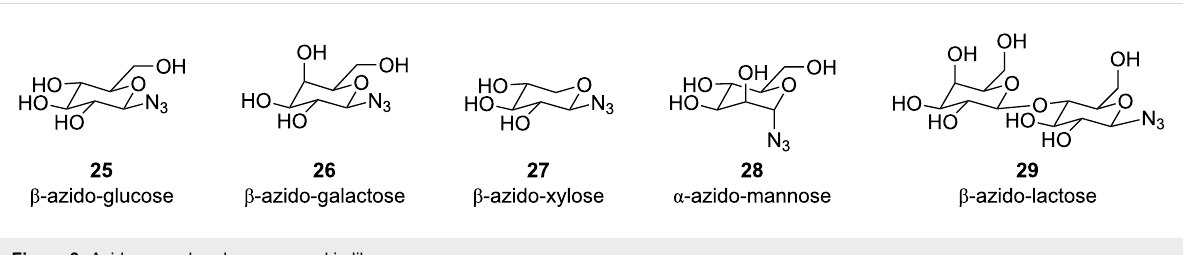
Figure 3: Azido-sugar head groups used in library.